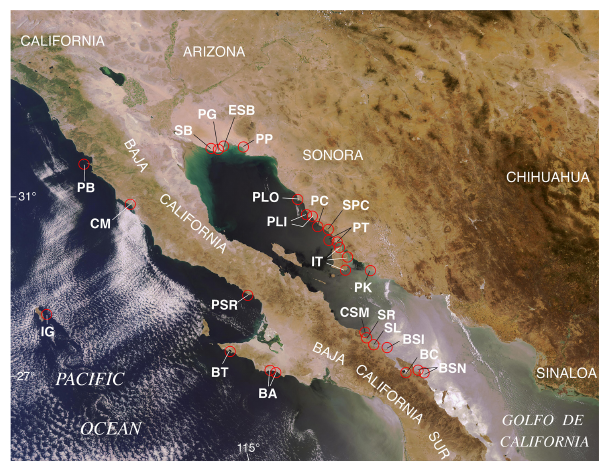
Figure 33. Satellite image of northwestern Mexico (Baja Cali- fornia, Baja California Sur, Sonora, and parts of adjacent areas) showing localities (red circles) where amino acid